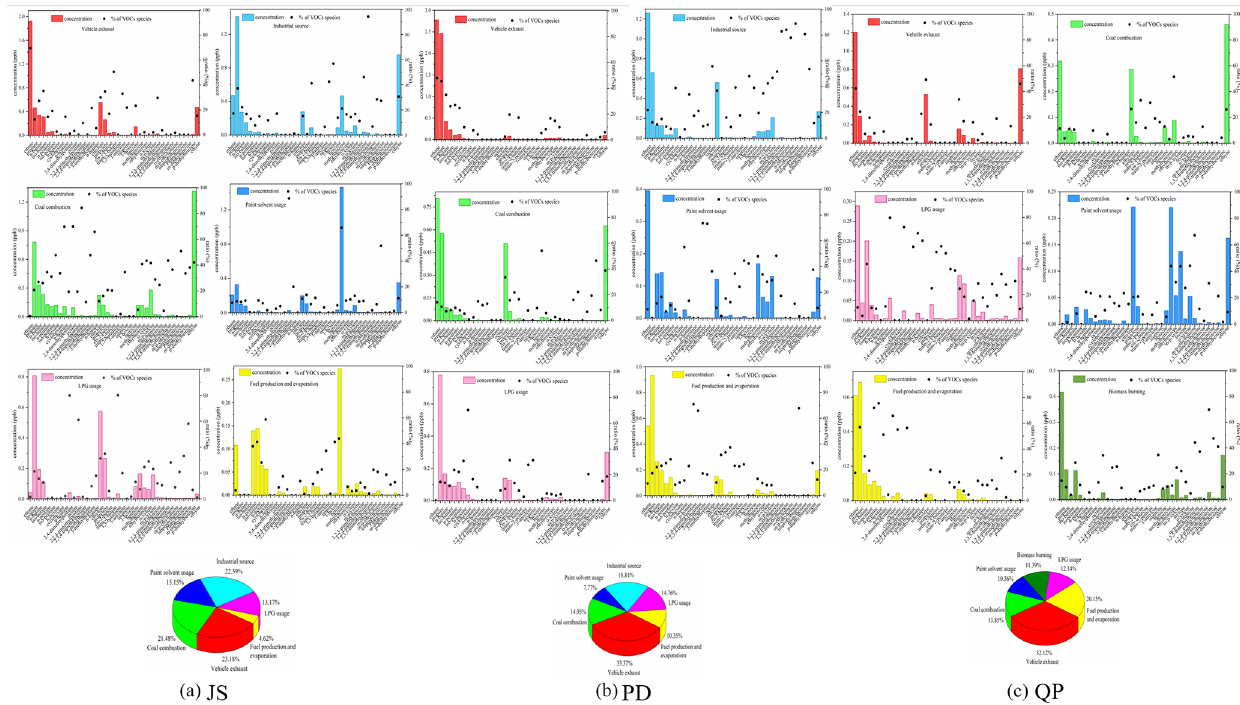
Figure 6. Source profiles and contributions of VOCs at the (a) JS, (b) PD and (c) QP sites.